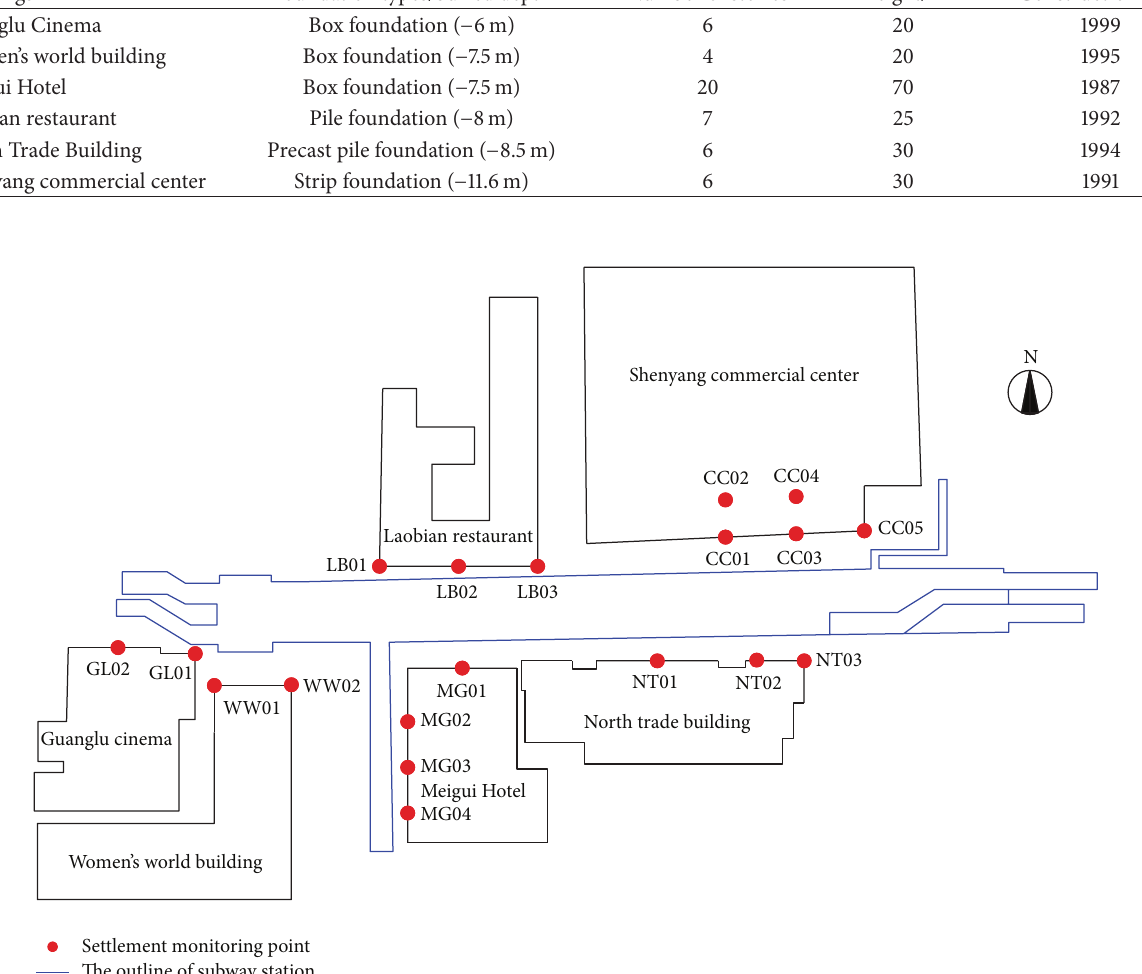
Figure 9: Zhongjie station and surface buildings relative